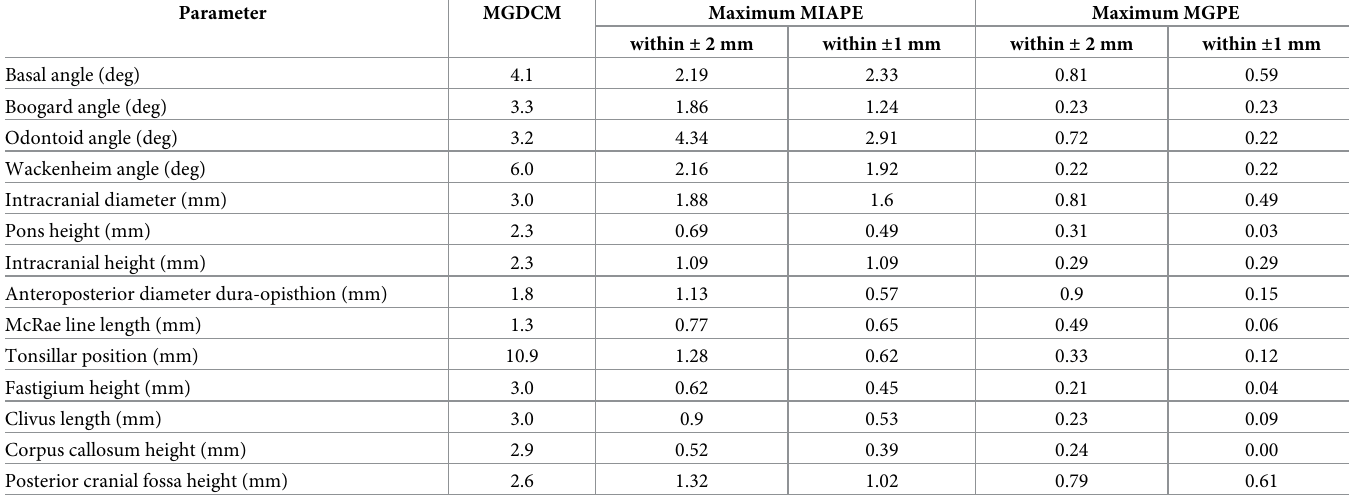
Table 3. Comparison between maximum mean individual absolute parasagittal error (MIAPE), maximum mean group parasagittal error (MGPE), mean group dif- ferences between Chiari subjects and healthy controls (MGDCM) for each morphometric parameter.